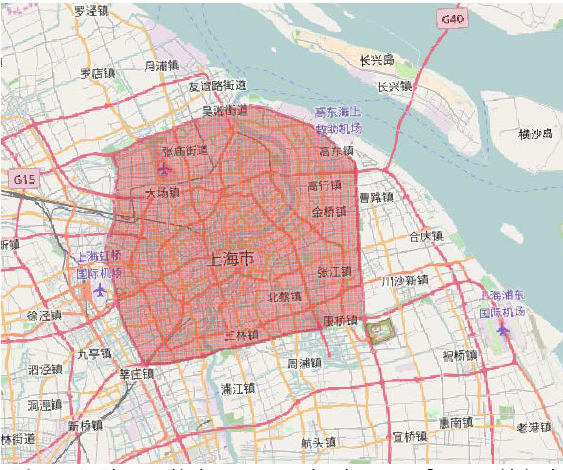
Figure 6. The studied area: We take the central area within the outer ring of Shanghai as the studied area and divide the area into 4422 uniform grids whose size is 500m×500m.